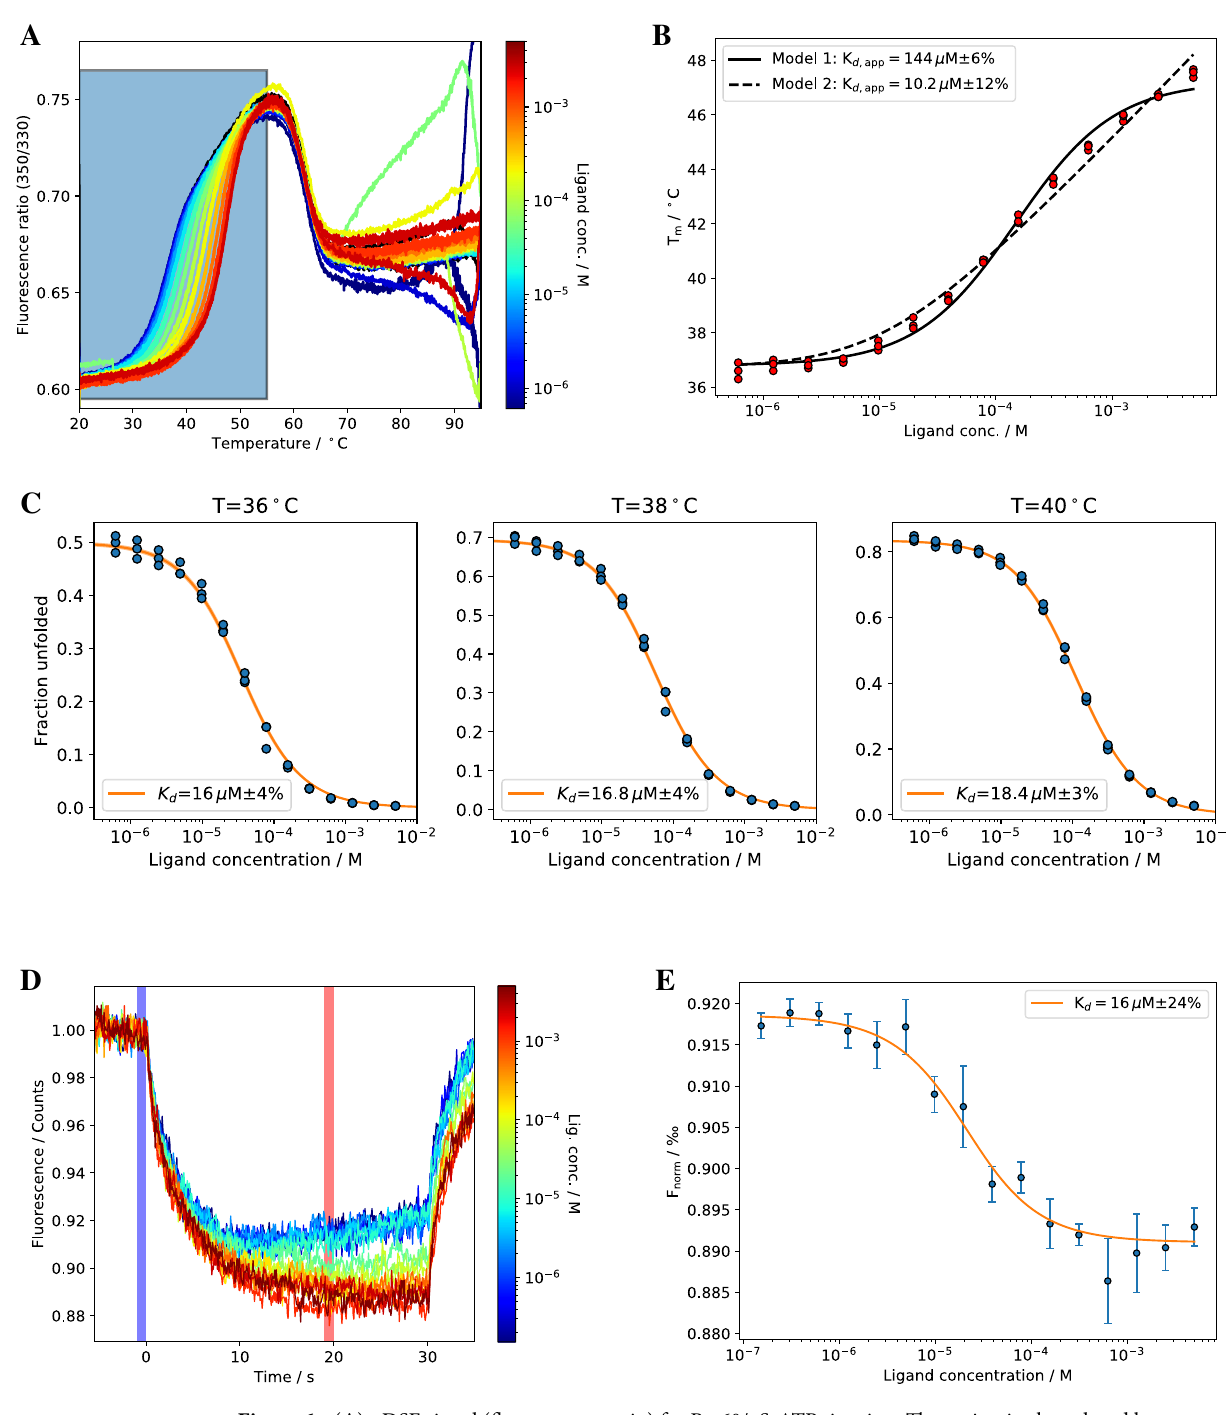
Figure 6. ( A ) nDSF signal (fluorescence ratio) for Pcs60/ γ S-ATP titration. The region in the colored box was used for isothermal analysis (shown in C ). ( B ) Melting temperature analysis with two different models yields apparent K d,app values. ( C ) Isothermal analysis of nDSF data for ∆ C p = 0 at three selected temperatures. The same analysis for a fitted ∆ C p (cf. Table 1) is shown in supplementary information S28. ( D ) MST experiment with Pcs60/ γ S-ATP. The “cold” and “hot” regions used for calculating F norm are marked as blue and red shadows, respectively. ( E ) Fitting F norm to a 1:1 model yields a K d of 16